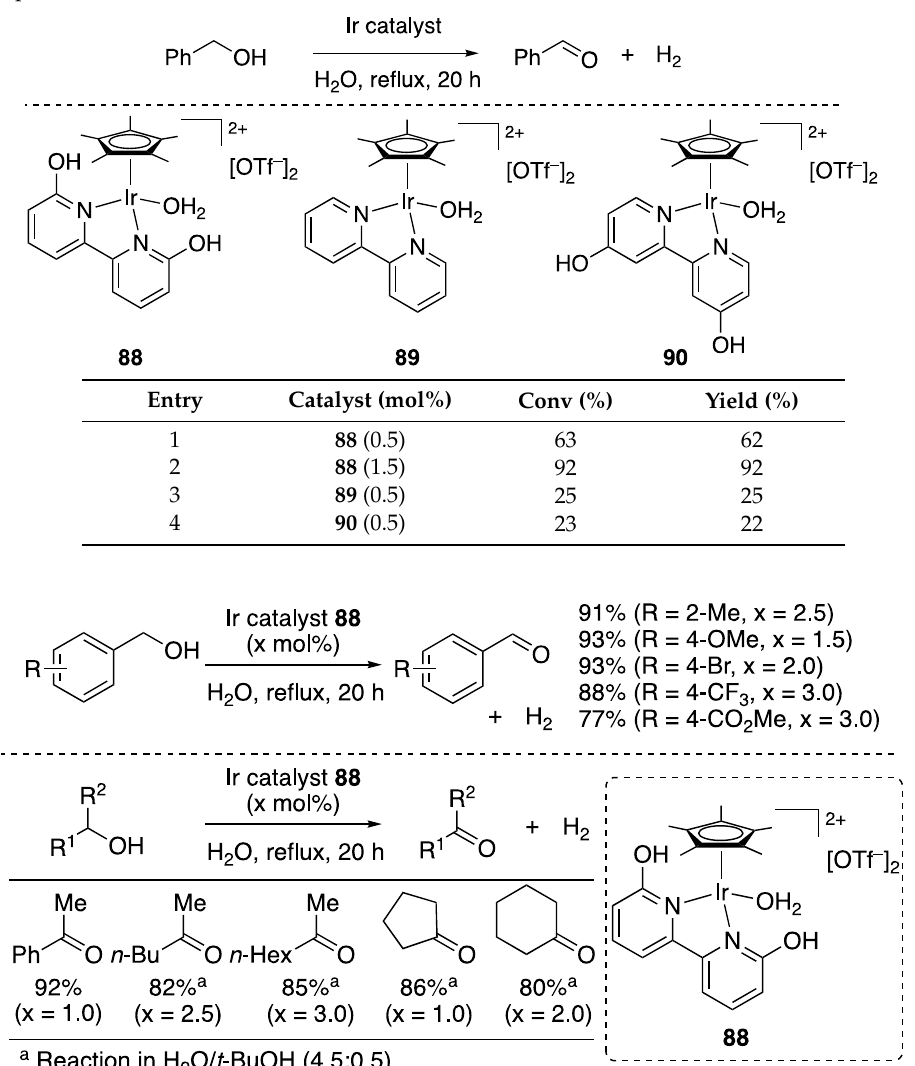
Table 2. Dehydrogenative oxidation of benzyl alcohol to benzaldehyde in water catalyzed by Ir complexes.